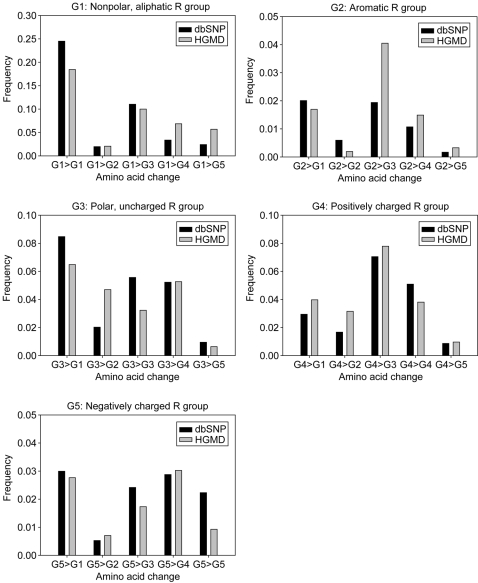
Distribution of amino acid change frequencies according to amino acid group (G1, nonpolar, aliphatic R group; G2, aromatic R group; G3, polar, uncharged R group; G4, positively charged R group; and G5, negatively charged R group).Black vertical bars indicate group [S-C] in dbSNP and gray vertical bars indicate group [M-C] in HGMD.